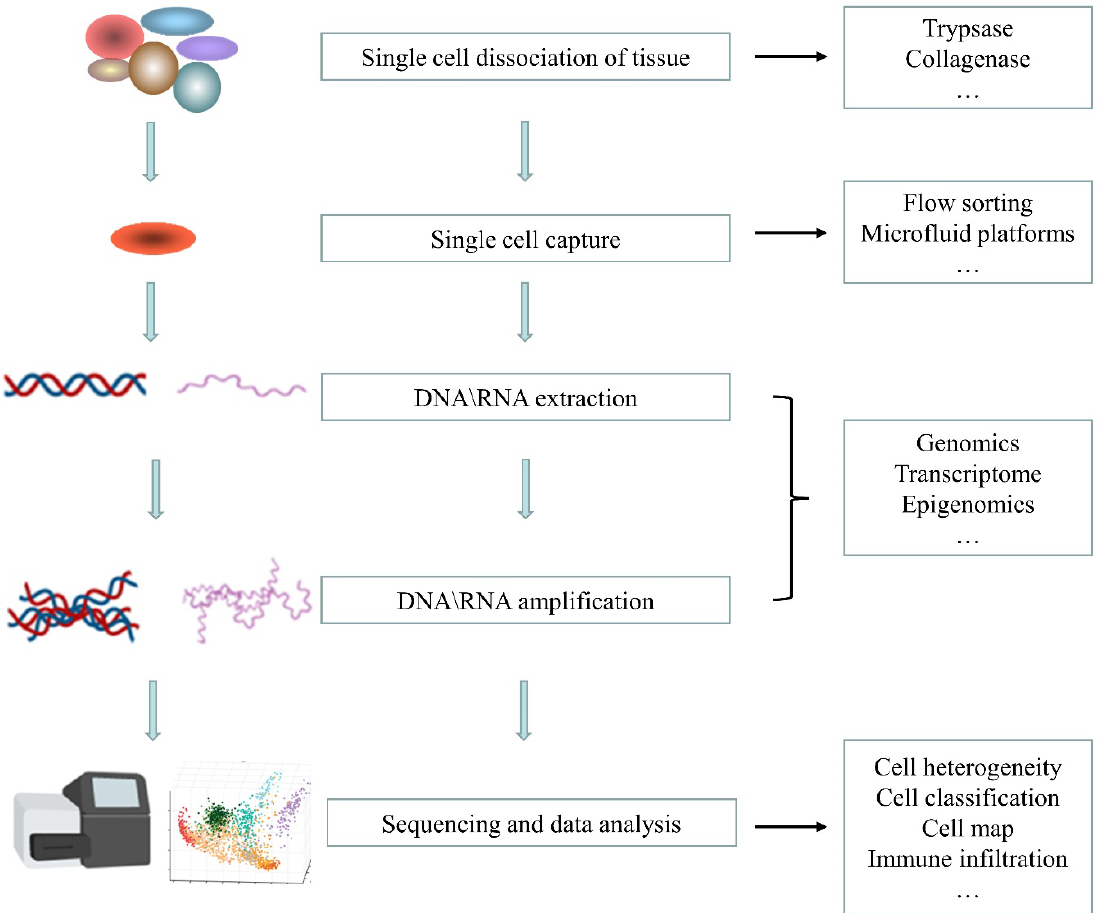
Figure 1. Schematic of single-cell sequencing.